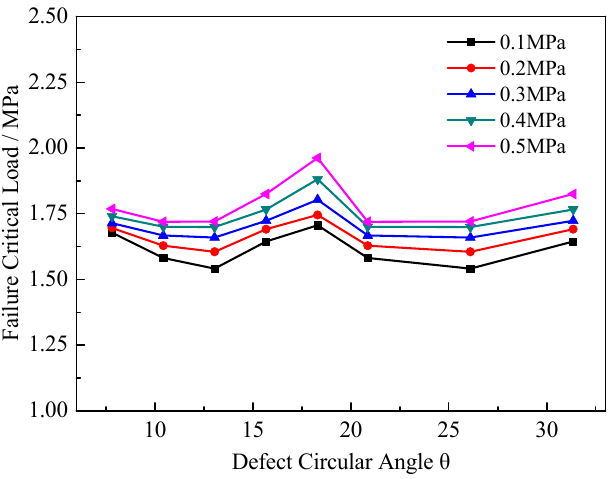
Figure 22. Critical failure load of HDPE pipe with various defect widths. Figure 23 shows the distribution of pipeline failure position with defect width. The pipeline failure positions are located on the inner wall of the arch camber line on both sides of the pipe. As the defect width increased, the failure area on the inner wall of the pipeline at the defect position gradually